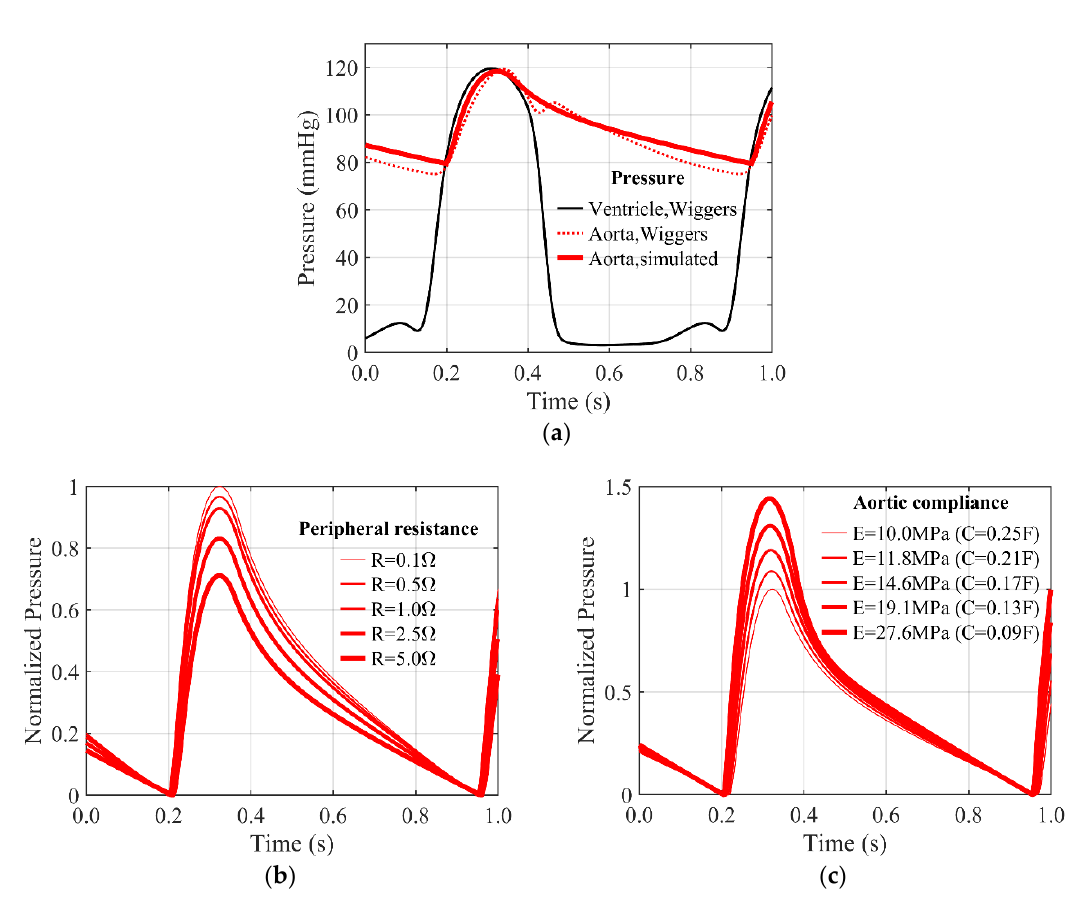
Figure 7. Parametric study of the mock circulatory platform simulation model: ( a ) simulated ventricular and aortic pressure waveforms; ( b ) normalized aortic pressure according to various peripheral resistance; ( c ) normalized aortic pressure according to various aortic compliance. Table 4. Comparison of the mock circulatory platform and the 4-elements windkessel model.